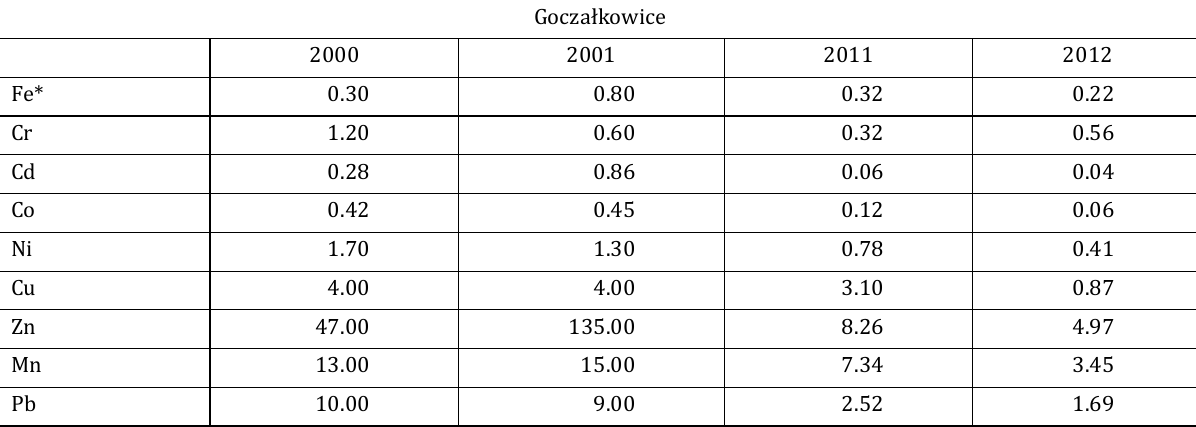
Table 5. Total annual dry deposition values in Goczałkowice in 2000, 2001, 2011, 2012. [mg/m 2 ], Fe* – [g/m 2 ]